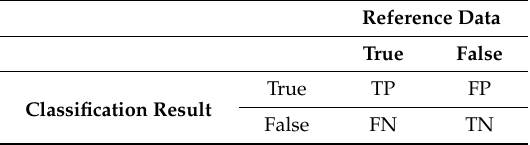
Table 3. Example binary confusion matrix and associated